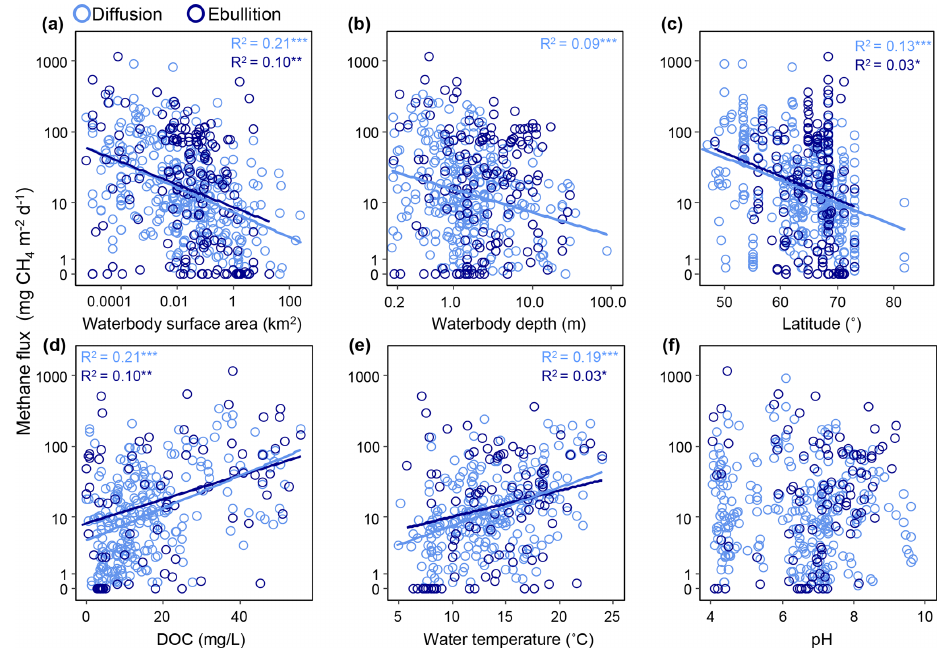
Figure 10. Relationships between site-averaged ice-free diffusive and ebullitive CH 4 fluxes (note the log scale) and environmental variables. Environmental variables include surface area, waterbody depth, latitude, dissolved organic carbon (DOC) concentration, water temperature, and pH. Regression lines and R 2 values are shown for significant relationships. Log diffusive CH 4 flux was linearly related to surface area, depth, latitude, water temperature, and DOC. Log ebullitive fluxes were linearly related to surface area, latitude, DOC, and water temperature. ∗